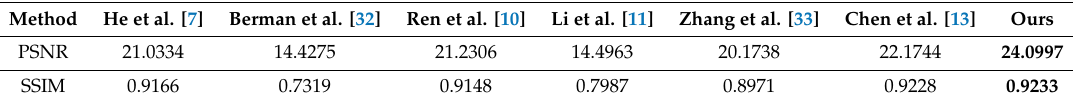
Table 2. Quantitative evaluation results of railway images dehazing.